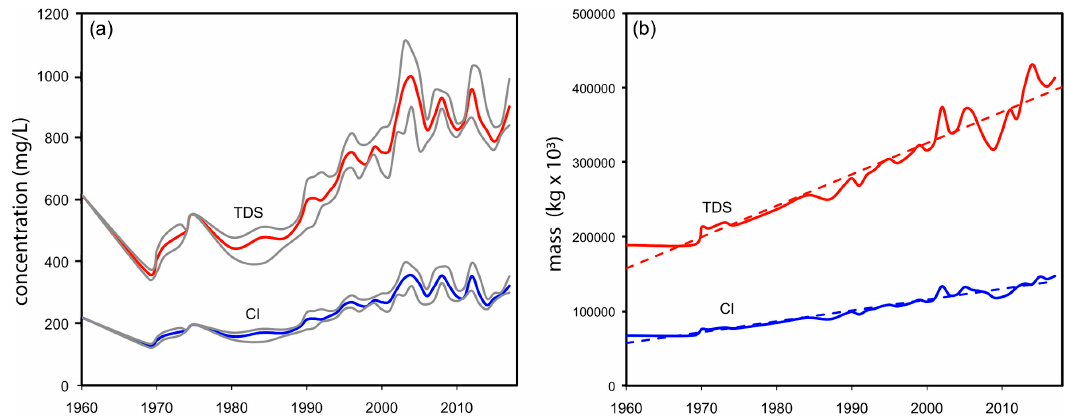
Figure 10. ( a ) Average values of TDS (red curve) and Cl (blue curve) from 1961 to 2018. Grey curves indicate the range of variation of the two variables; ( b ) total mass of dissolved ions (red) and total mass of chloride (blue) from 1961 to 2018, dotted lines represent the linear best fit of the data. Our dataset is completed with data from Ludovisi and Gaino [5], Mearelli et al. [18], ARPA-Umbria [35], Mannelli and Mancini [58], Tiberi [58,59]) and Tiberi et al. [60].